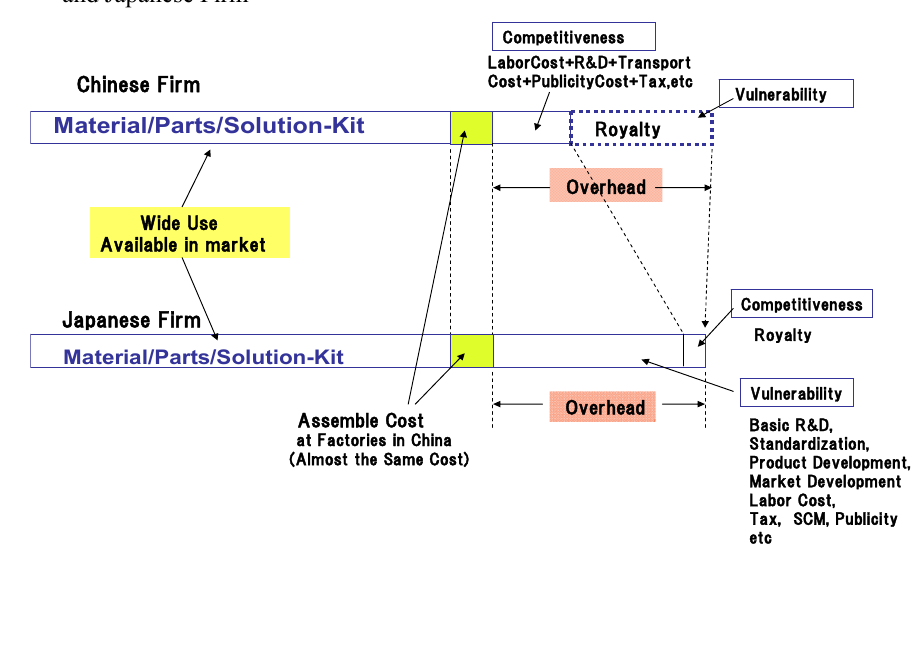
Figure 11. Product-cost and Overhead Comparison of DVD Drive between Chinese Firm and Japanese